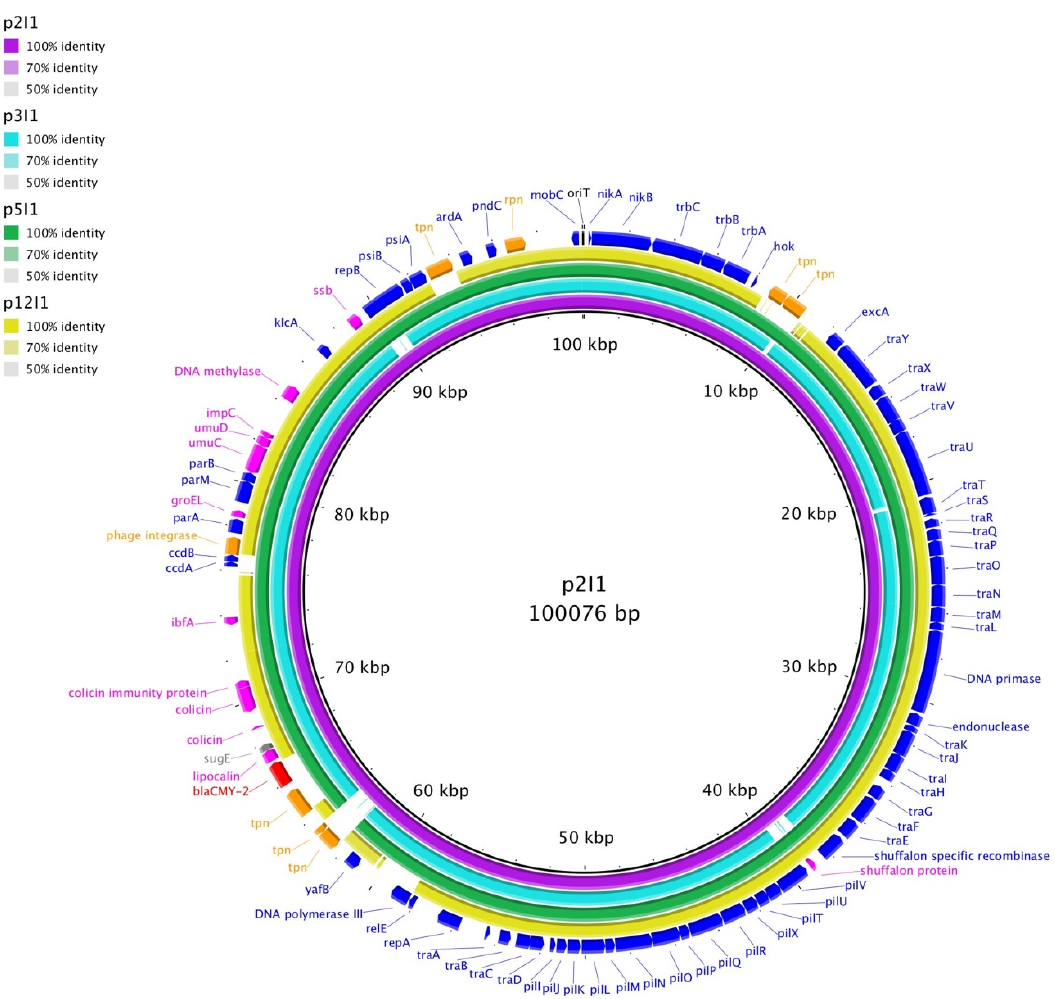
Figure 2. Blast comparison of IncI1 plasmids.